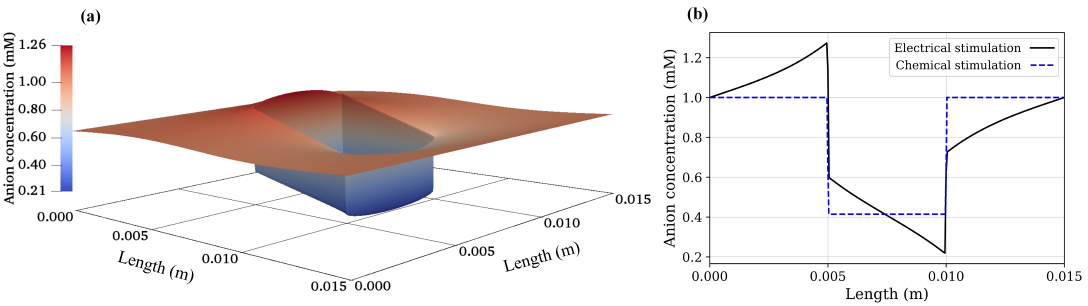
Figure 4. Cation concentration: ( a ) 2D electrical stimulation, ( b ) comparison of chemical and electrical stimulation versus x -position at y = 0.0075m.